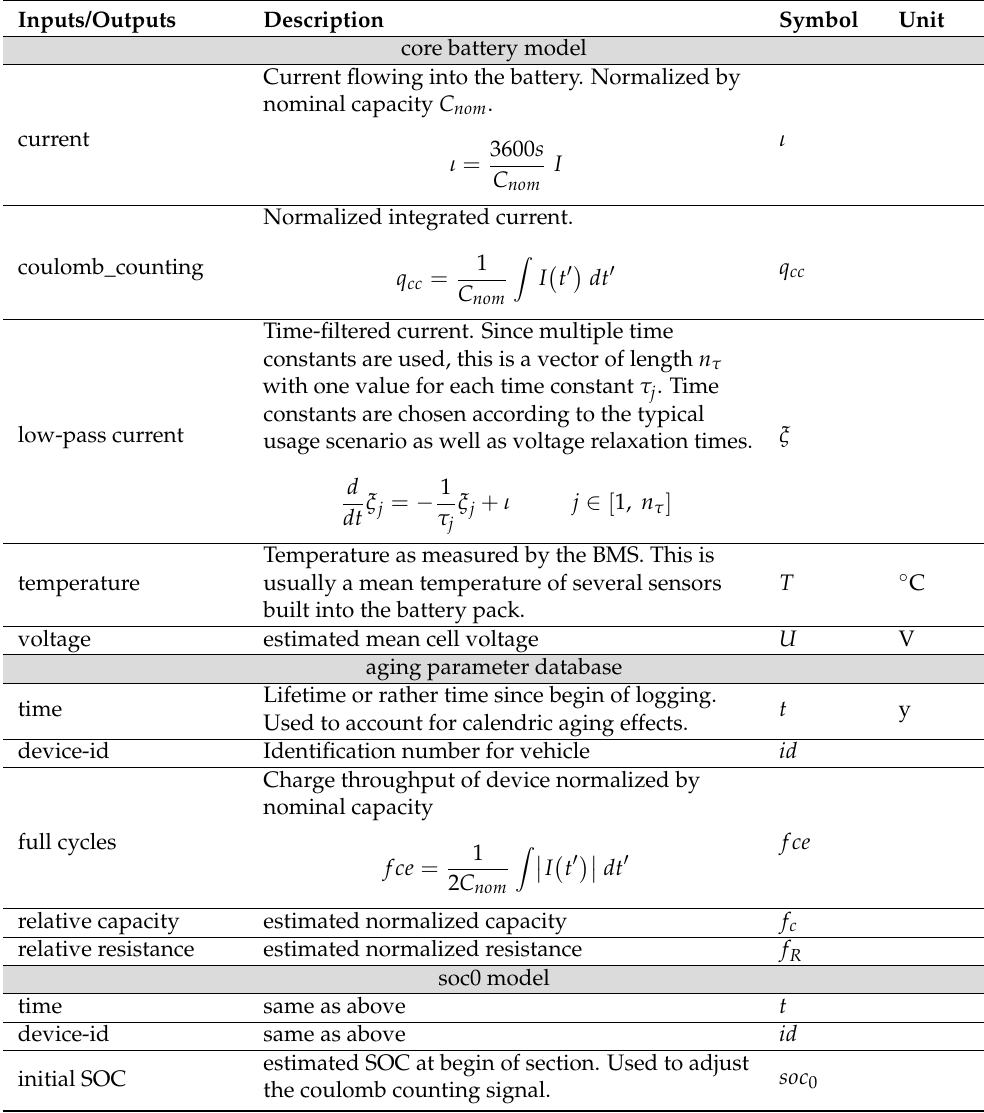
Table 2. Inputs and outputs of the fleet